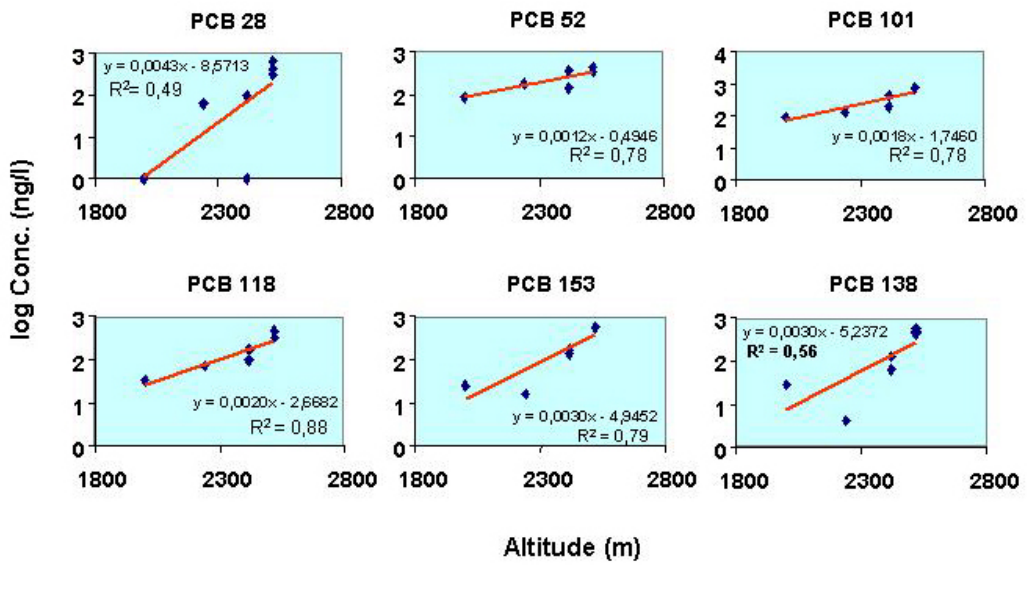
Figure 1. Concentrations of polychlorobiphenyl congeners in snow of high altitude